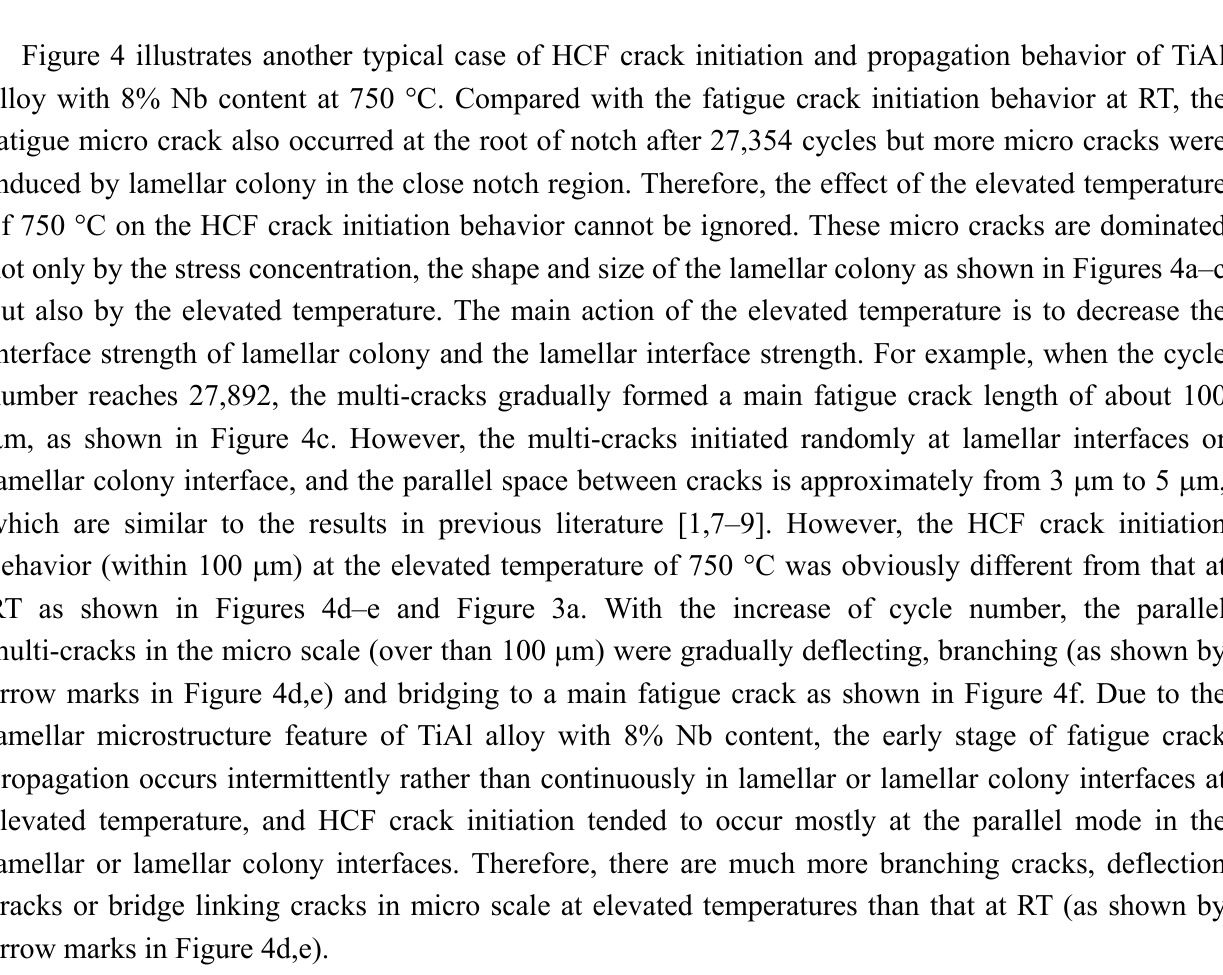
Figure 4. Fatigue crack propagation behavior of TiAl alloy with 8% Nb content at 750  C under different cycles of the same applied stress of about 395 MPa. ( a ) N = 27,354, (bar scale 50  m); ( b ) N = 27,482, (bar scale 50  m); ( c ) N = 27,892, (bar scale 50 